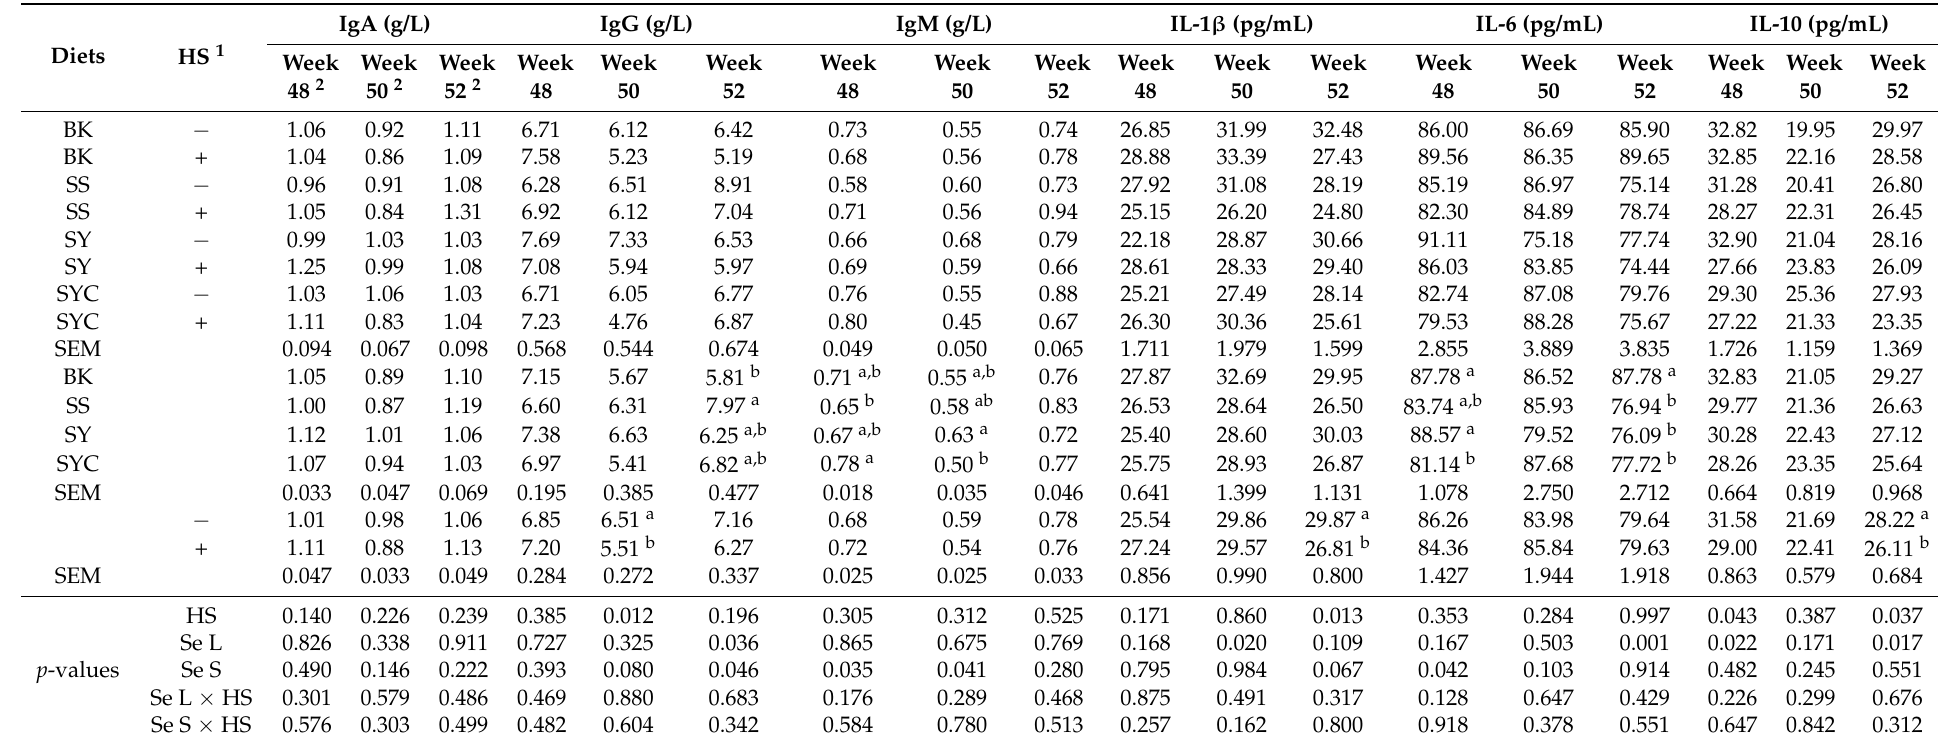
Table 7. Effects of different Se sources in diet on serum immune indexes of laying